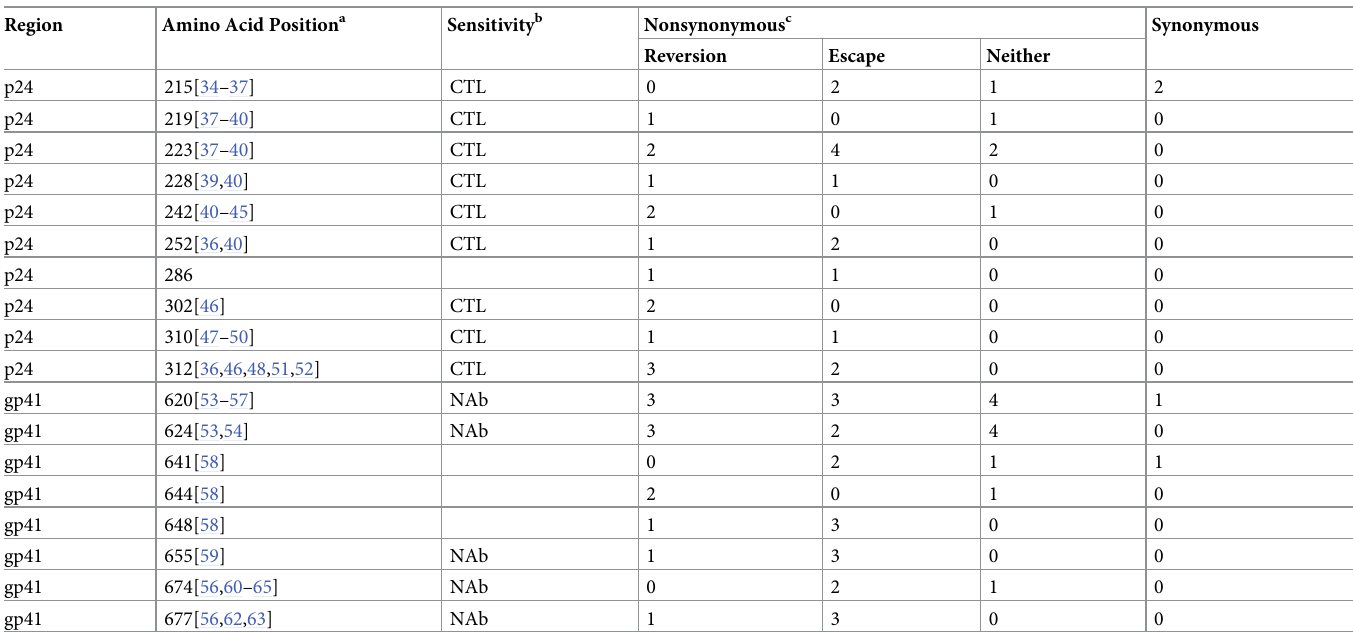
a Amino Acid (AA) positions in gag (p24) or env (gp41) relative to the HXB2 reference genome b Sensitivity to CTLs or NAbs using the Los Alamos HIV database (http://www.hiv.lanl.gov; see Methods for further details). AA position 228 in gag is associated with compensatory mutations, rather than affecting sensitivity to CTLs directly. Position 286 in gag occurs in an epitope position targeted by common HLA alleles in the Ugandan population and so is likely associated with CTL escape. Positions 644, 648 and 655 were not associated with sensitivity to NAbs, but are in an epitope region recognised by NAb HGF24 in some viruses isolated from Africa[58]. c A nonsynonymous change was classed as a reversion if the nucleotide changed towards the subtype-specific population-level consensus, as an escape if the nucleotide changed away from the subtype-specific population-level consensus, and as neither of these if there was a nucleotide change which remained different to the subtype- specific population-level consensus. mutations, and lie in epitope regions recognised by multiple HLA alleles present in the Ugan- dan population[66–68]. The remaining codon (residue 286 in HXB2 gag ) lies within CTL epi- topes recognised by human leukocyte antigen (HLA) alleles that are relatively common in the Ugandan population (A1101 and B27[66]) and therefore mutations at this site probably affect sensitivity to CTLs, or possibly compensatory mutations. In gp41, 44% of AA sites have previ- ously been associated with NAbs, whilst 61% of the variants we inferred to be under selection were associated with NAbs. Of the eight AA positions identified as being almost certainly under selection, five (residues 620, 624, 655, 674 and 677 of env ) have previously been associ- ated with NAbs, including broadly neutralising antibodies (bNAbs). These are associated with the gp120/g41 interface and the membrane-proximal external region (MPER). The other three codons (residues 641, 644 and 648 of env ) all lie within an epitope region that is targeted by the monoclonal antibody HGF24, which has been shown to neutralise some viruses isolated from the African continent[58]. Although we cannot rule out other sources of selection in env , given the position of these codons on the genome, we believe selection due to humoral immune pres- sure is more likely. As such, all of the sites we identified as under selection in p24 probably affect susceptibility to CTLs or associated compensatory mutations, whereas all of the sites under selection in gp41 probably affect susceptibility to NAbs or associated compensatory mutations.